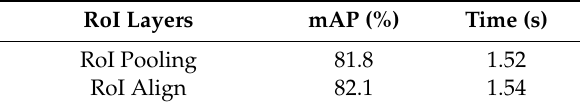
Table 3. Experiment results depend on different RoI layers.